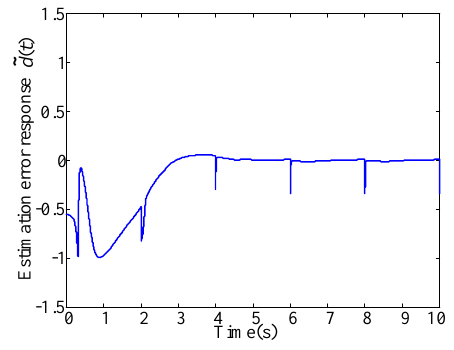
Figure 9. Estimation error response of SMO.